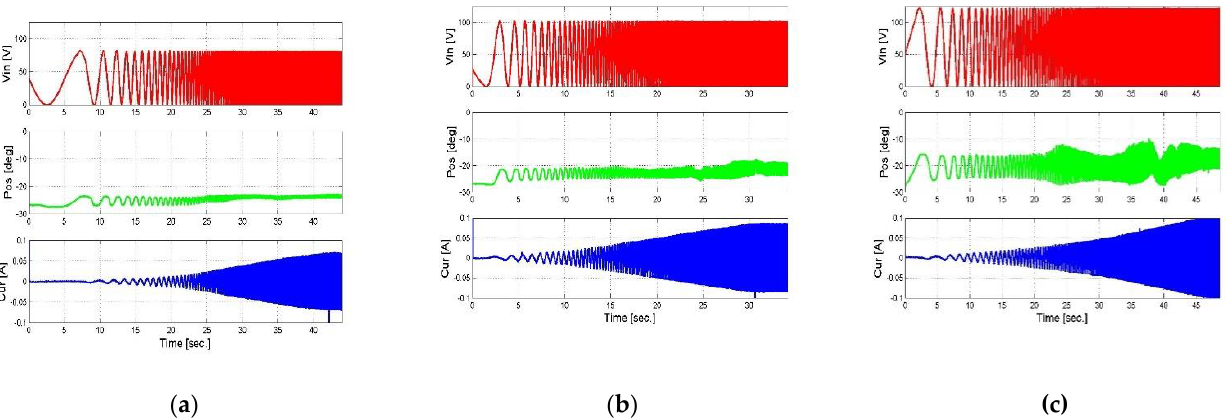
Figure 11. Measurement of output angle and current as results of the chirp input signal when the second load is applied. ( a ) Vin = 80 V, ( b ) Vin = 100 V, ( c ) Vin = 120 V.